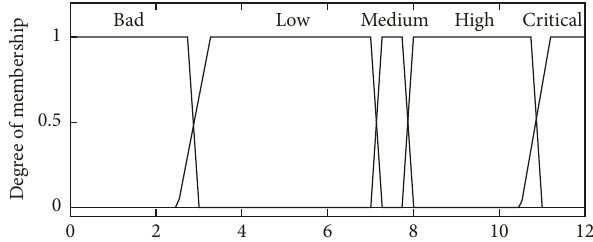
Figure 3: Input parameter membership function-CO